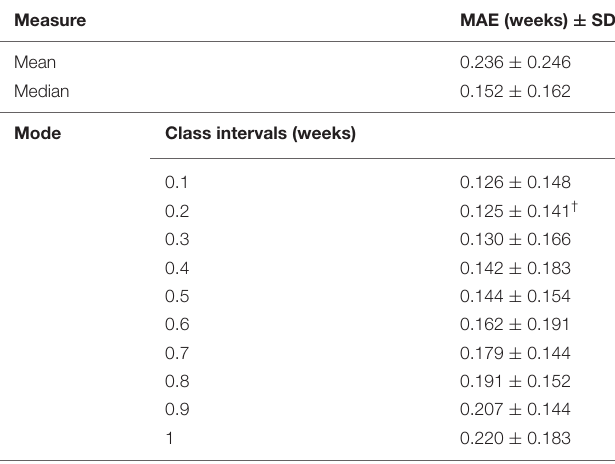
TABLE 1 | Prediction performances using different measures of central tendency for multiple age